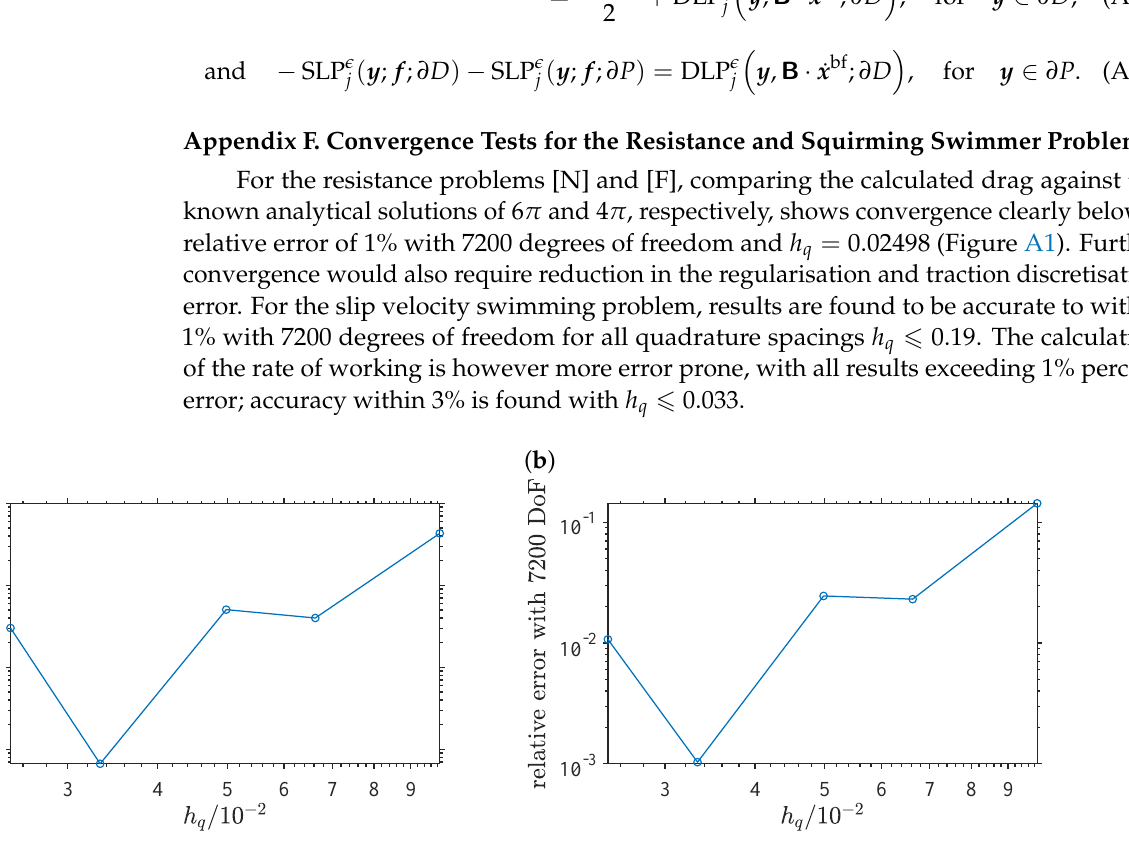
Figure A1. Numerical convergence of the resistance problem with quadrature spacing h q at fixed force discretisation 3 N = 7200, calculated with the nearest-neighbor discretisation and the full regularised stokeslet boundary integral formulation with ( a ) no-slip condition and ( b ) free-slip